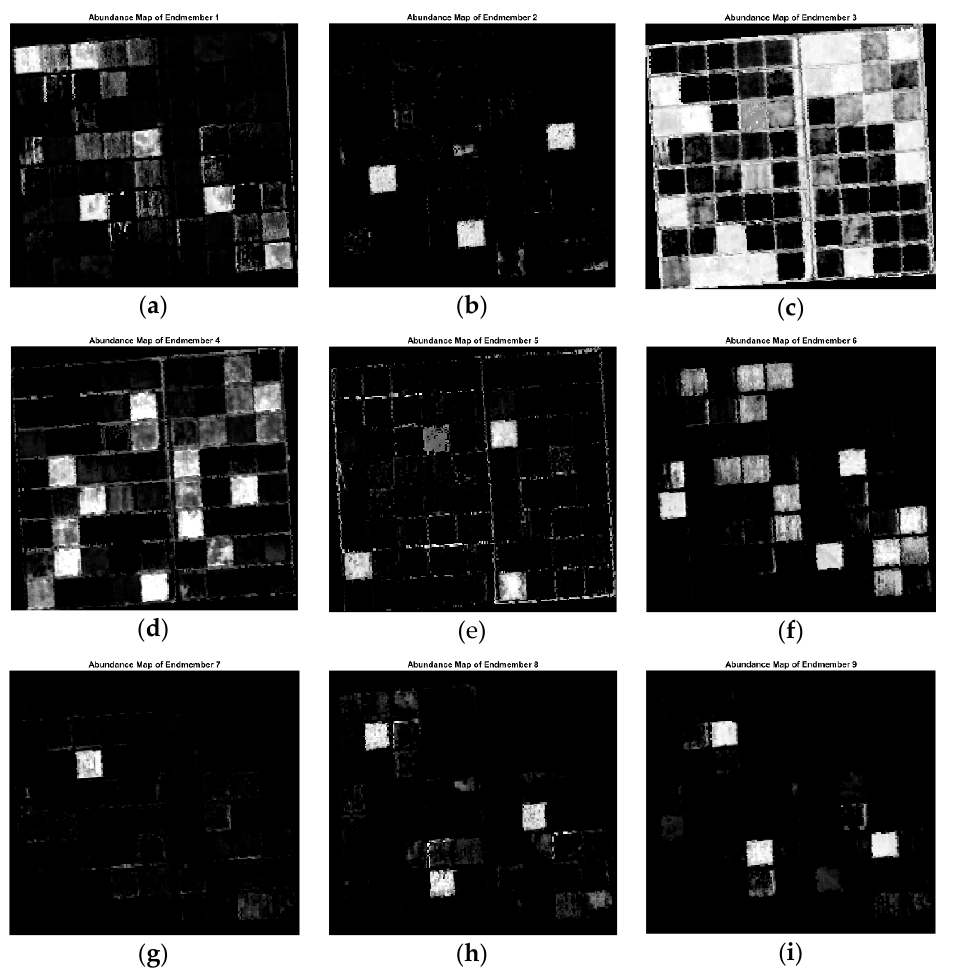
Figure 18. The estimated fractions using the selected bands by the ISI-PS method in an unsupervised manner for: ( a ) Corn; ( b ) Alfalfa; ( c ) Bare soil; ( d ) Wheat; ( e ) Native grass; ( f ) Tomato; ( g ) Weather station; ( h ) Corn; and ( i ) Corn.